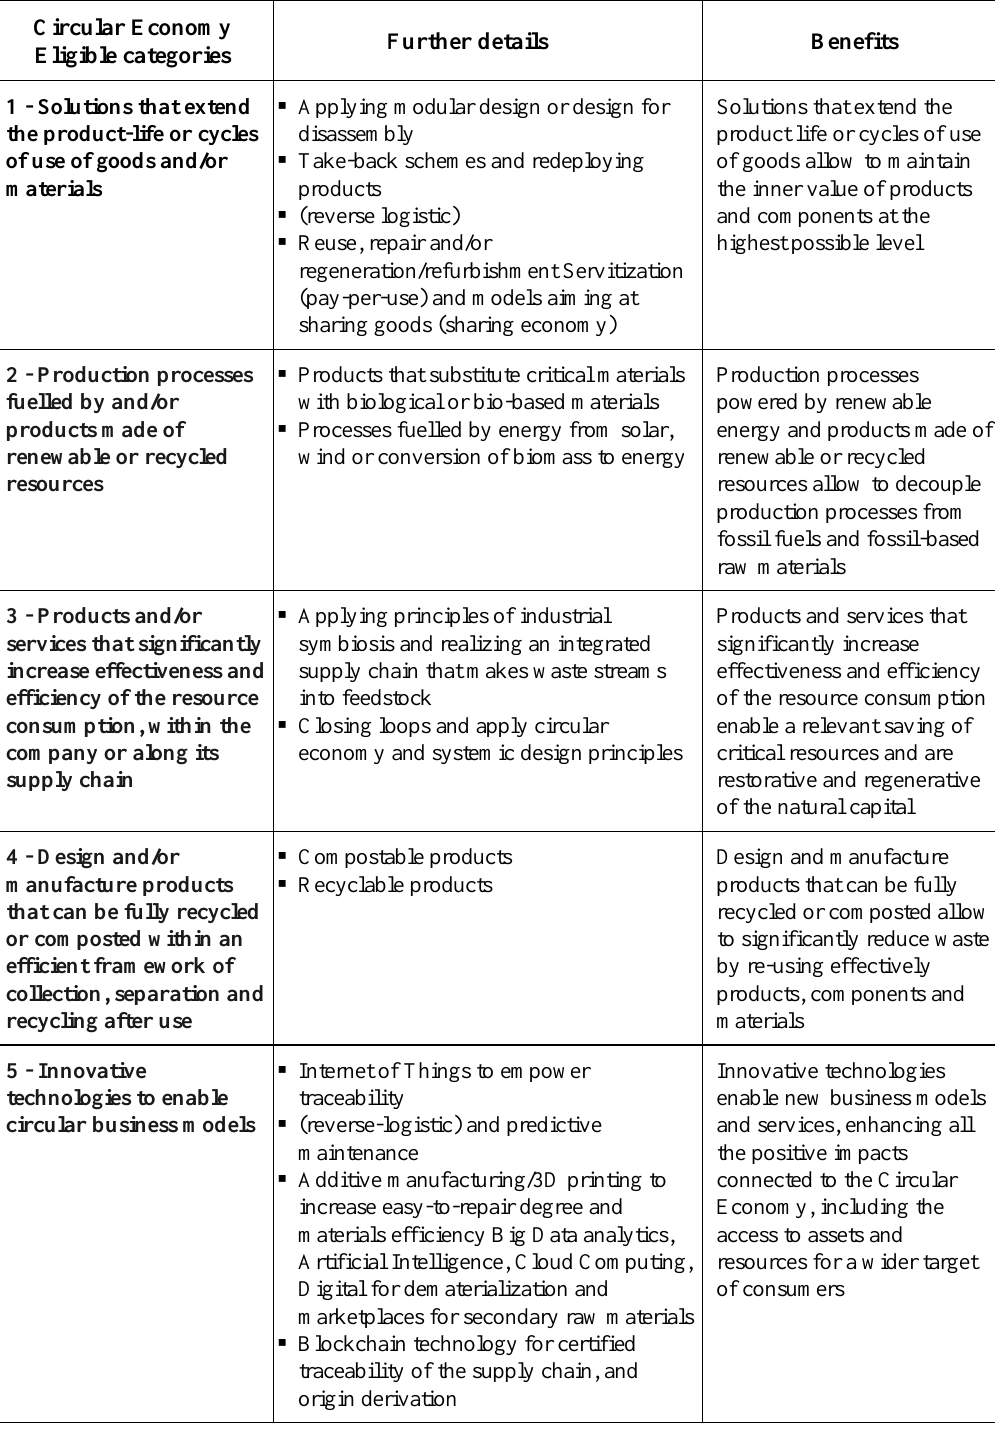
Table 1: Eligibility Criteria to Be